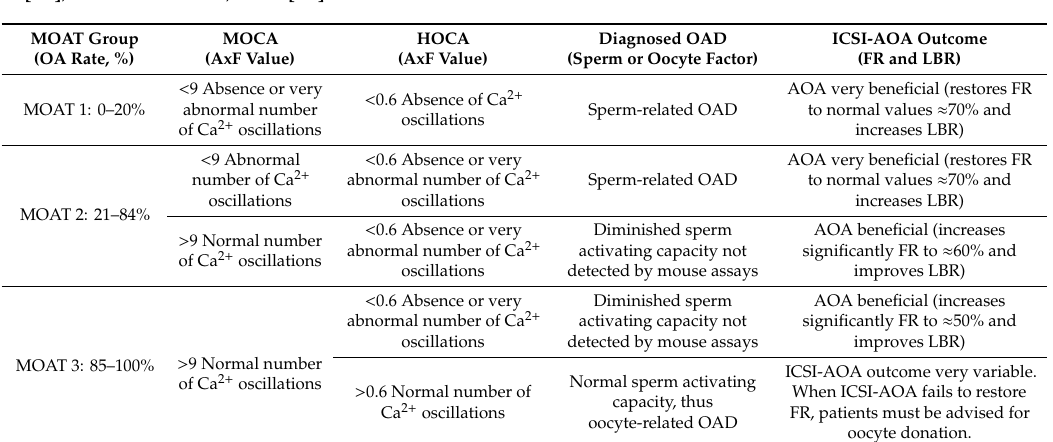
Table 1. Correlation of MOAT, MOCA and HOCA diagnostic test results with ICSI-AOA (assisted oocyte activation) outcomes. The presented data are based on the articles from Heindryckx et al., 2005 [48]; Heindryckx et al., 2008 [107]; Vanden Meerschaut et al., 2013 [49]; Ferrer-Buitrago et al., 2018 [50]; and Bonte et al., 2019